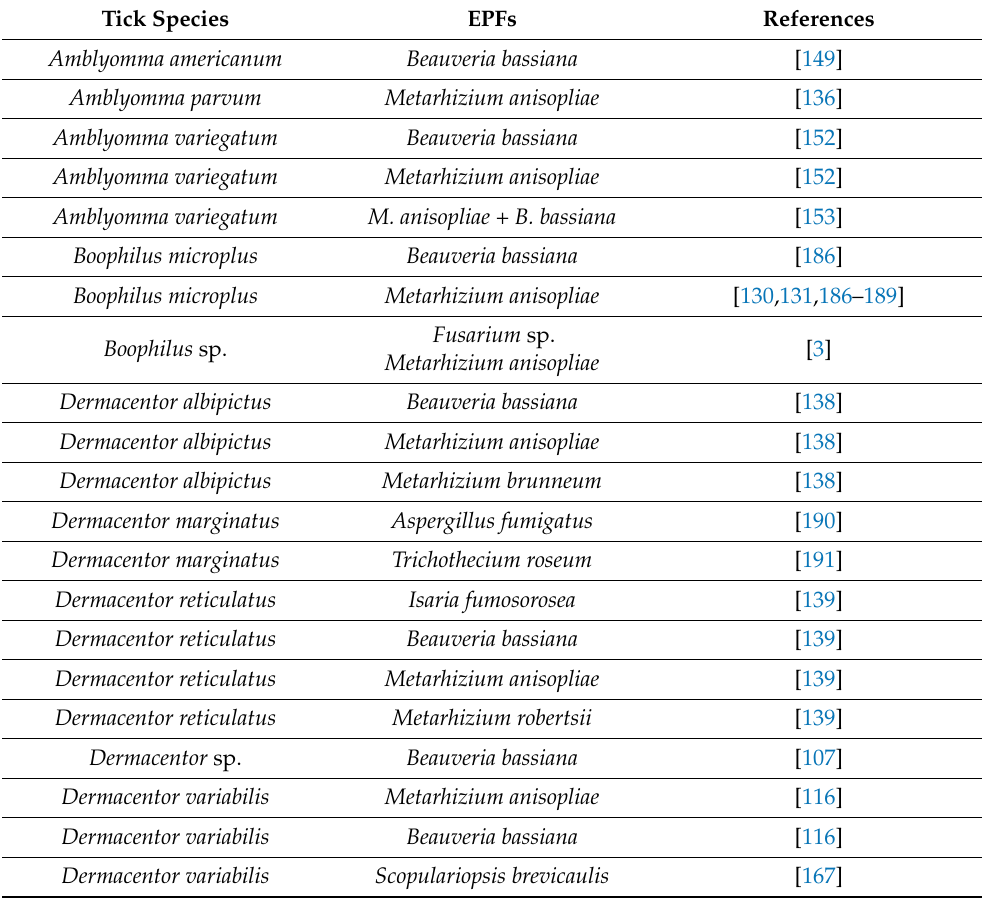
Table 1. Entomopathogenic fungi (EPFs) active versus different tick